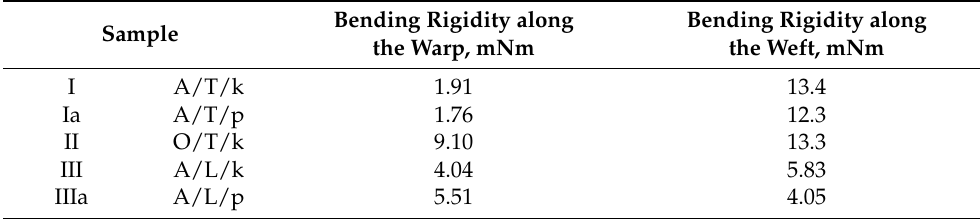
Table 5. Results of bending rigidity test for MLW fabrics.